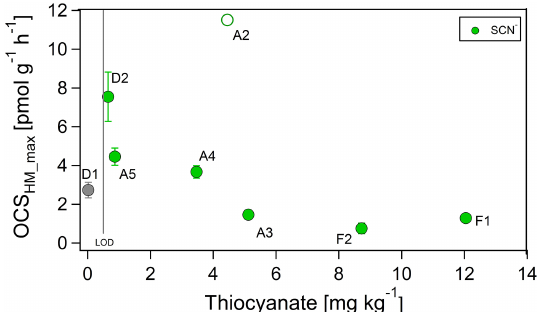
Figure 2. Correlation between OCS exchange rate, OCS max , HM , and thiocyanate (SCN − ) at high soil moisture for samples F1, F2, A3, A4, and A5 (green). Thiocyanate was below limit of detection (LOD of 0.5mgkg − 1 ) for D1 soil